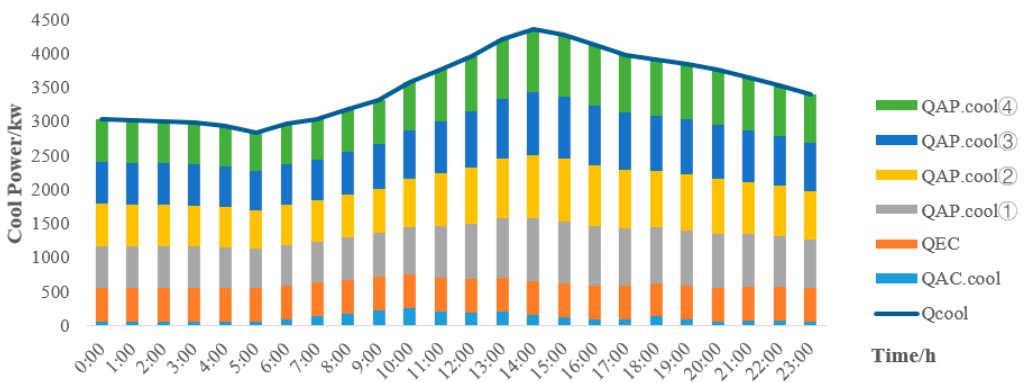
Figure 10. Cooling output diagram of various equipment before multi-time scale in summer.